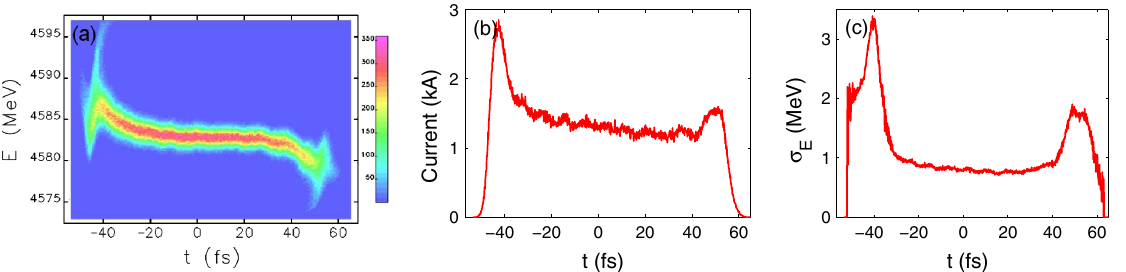
FIG. 10. Electron beam longitudinal phase space (a); electron beam peak current distribution (b); electron beam slice energy spread (c).